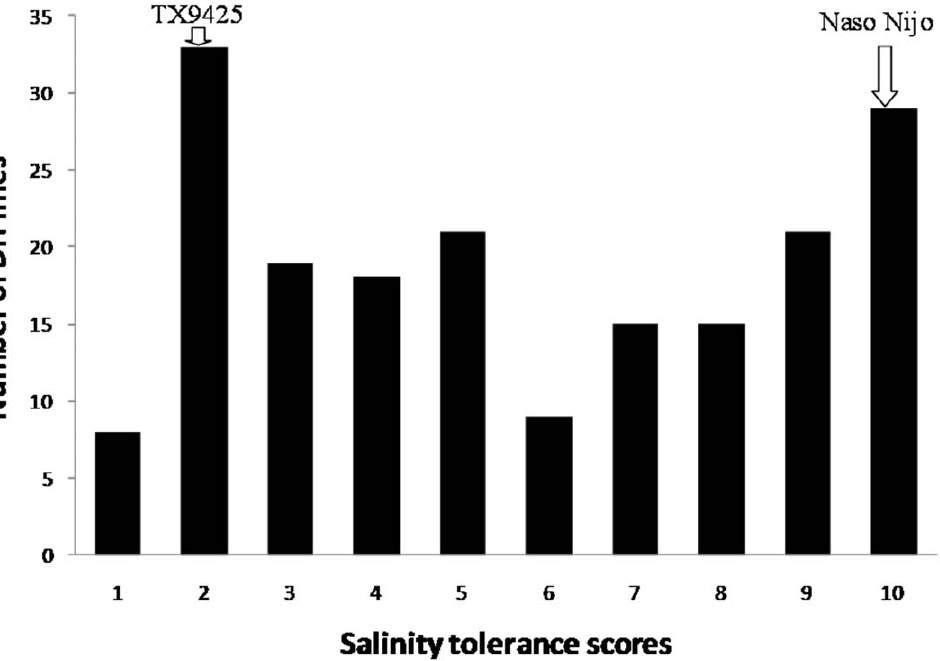
Figure 2. Frequency distribution for salinity tolerance at the booting stage of the DH lines derived from the cross of TX9425/Naso Nijo.